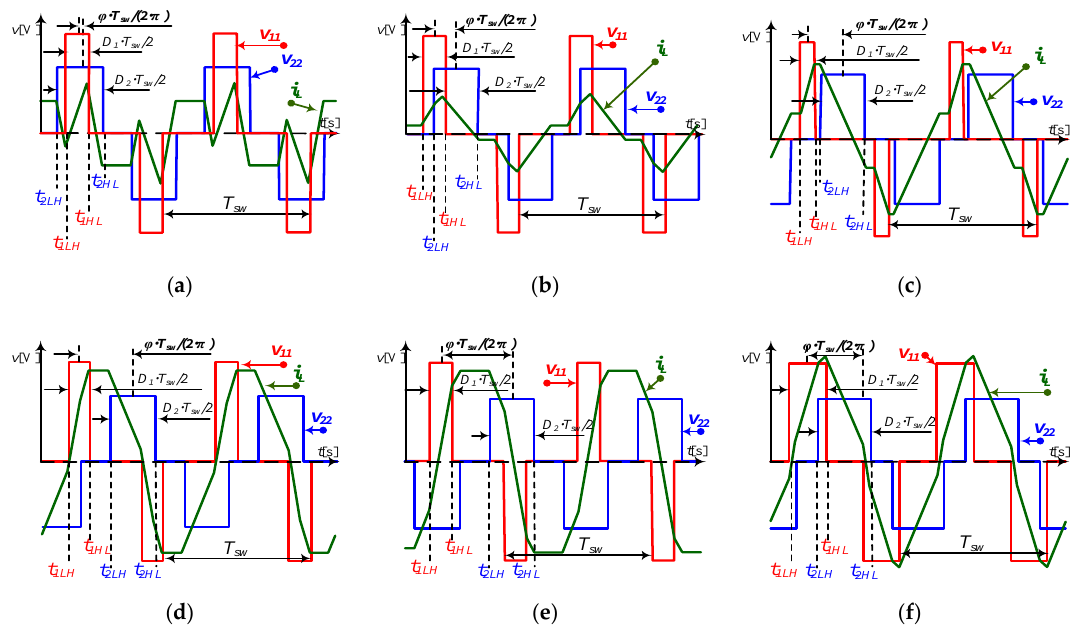
Figure 5. Case II: Switching modes for φ > 0. ( a ) SM 1 ; ( b ) SM 2 , SM 2 *; ( c ) SM 3 ; ( d ) SM 4 ; ( e ) SM 5 , and ( f ) SM 3 *. Table 1. Boundaries for switching modes: Case I and Case II.